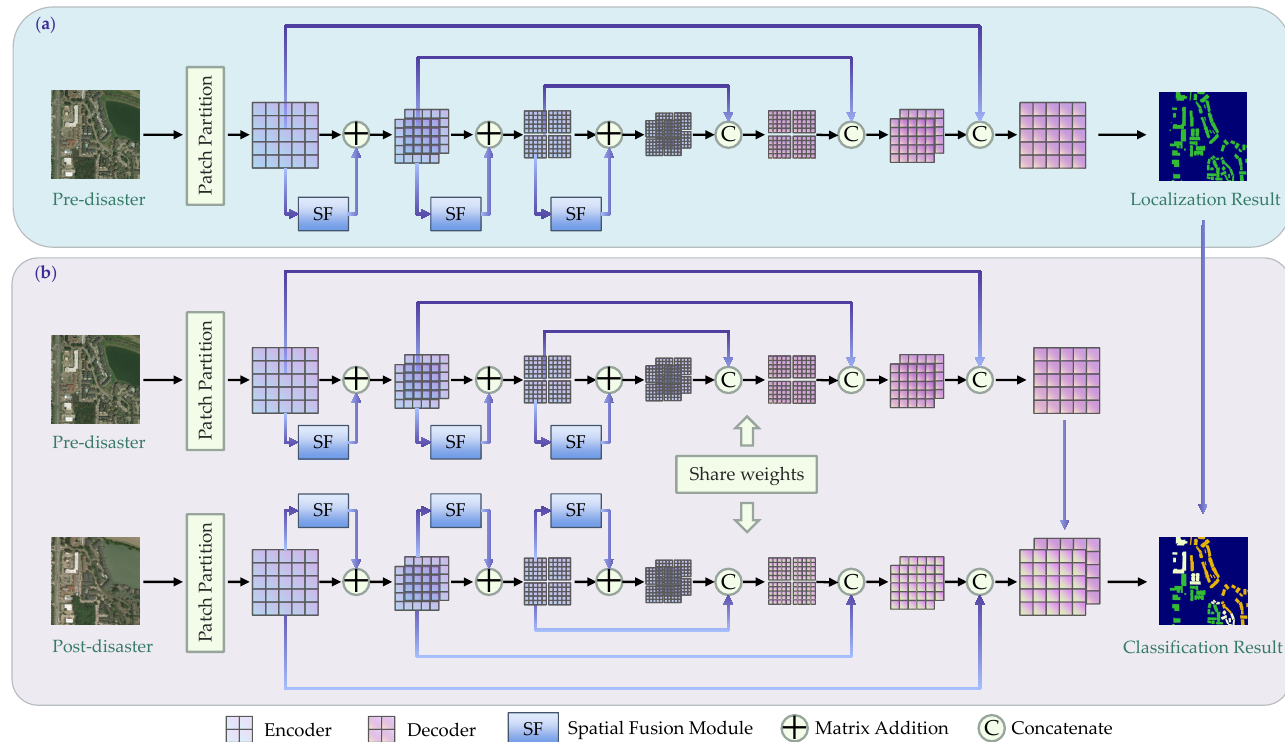
Figure 1. An overview of the SDAFormer framework. It is composed of two stages: ( a ) Stage 1: building localization, ( b ) Stage 2: damage